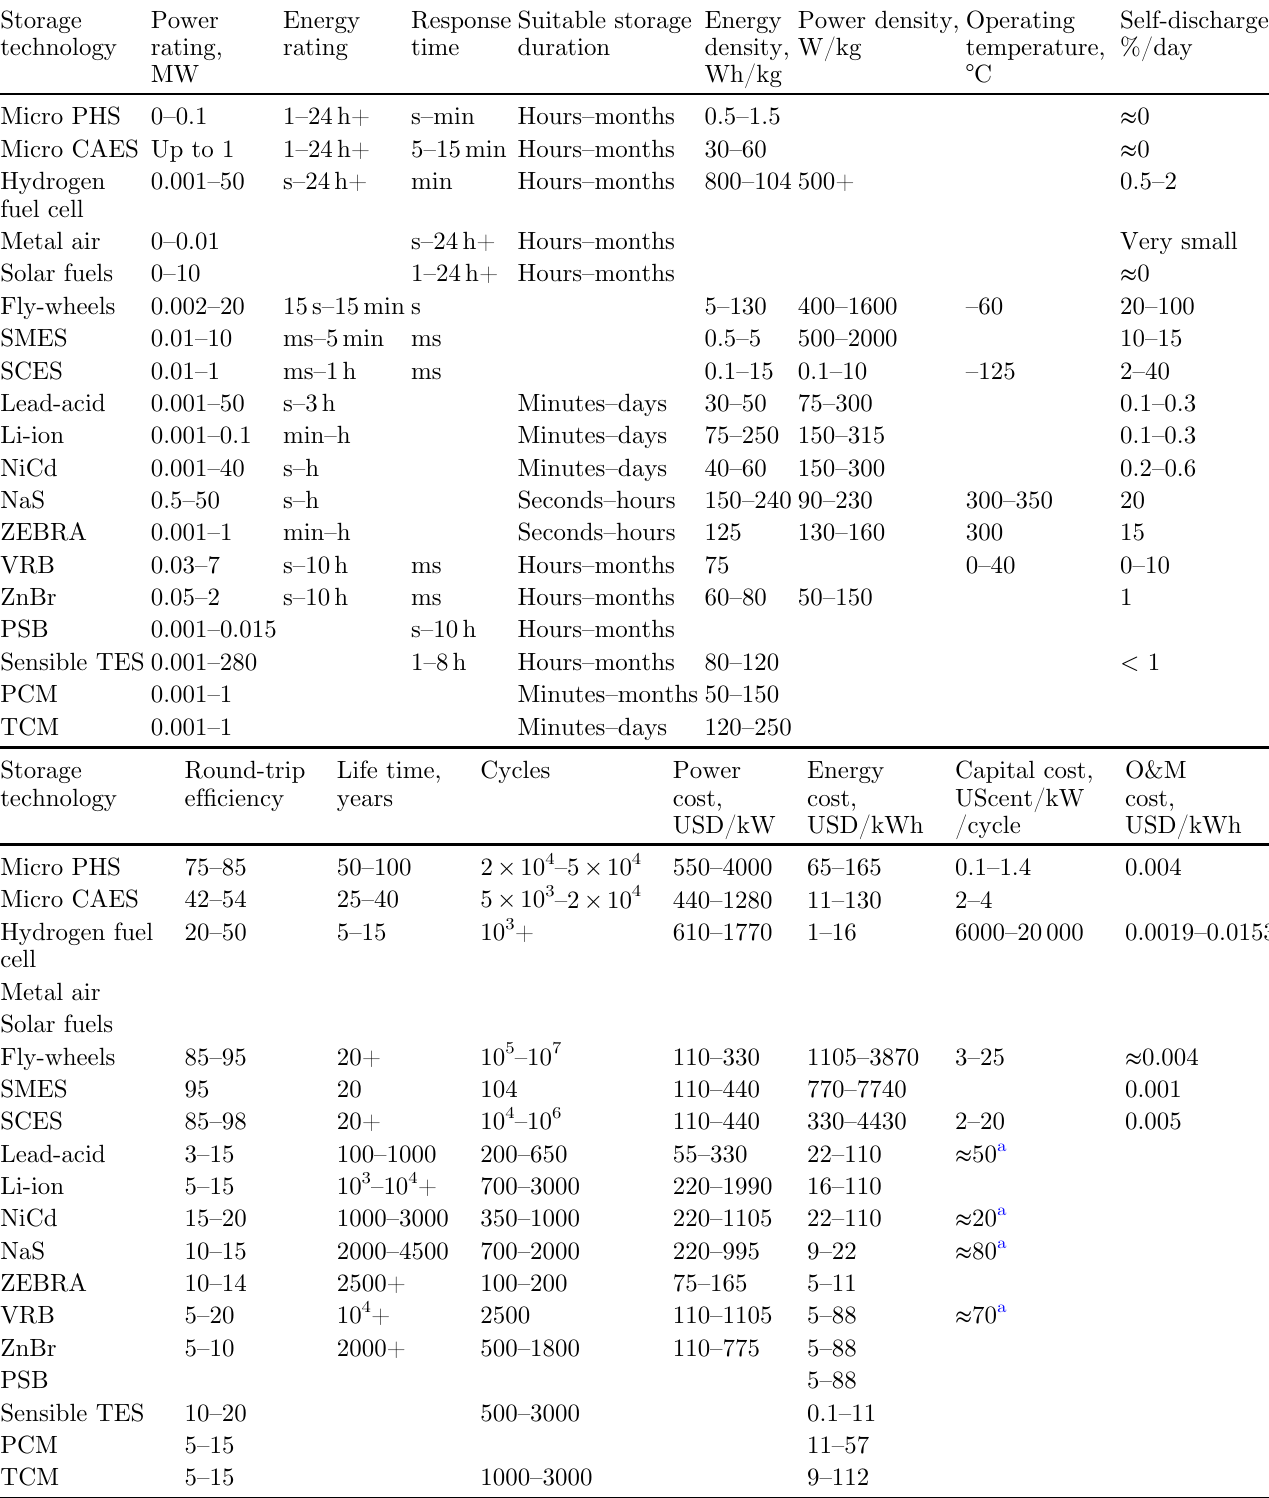
Table 2. Characteristics of small scale energy storage